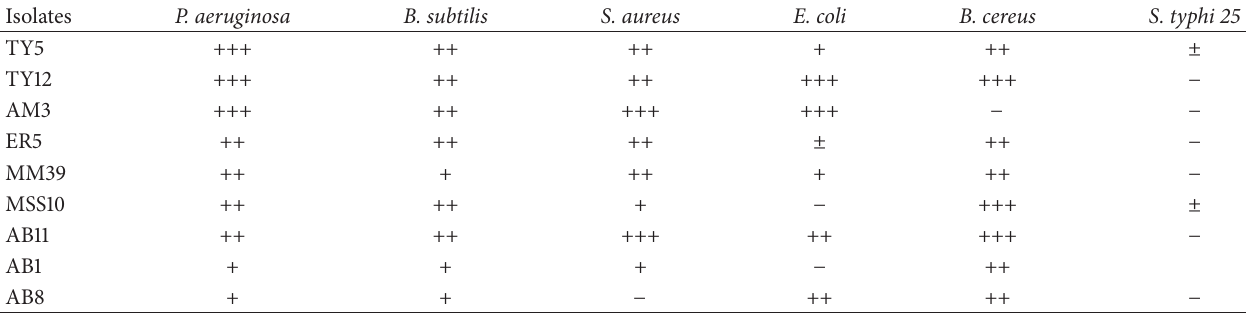
Table 5: Antimicrobial activity of LAB isolates.